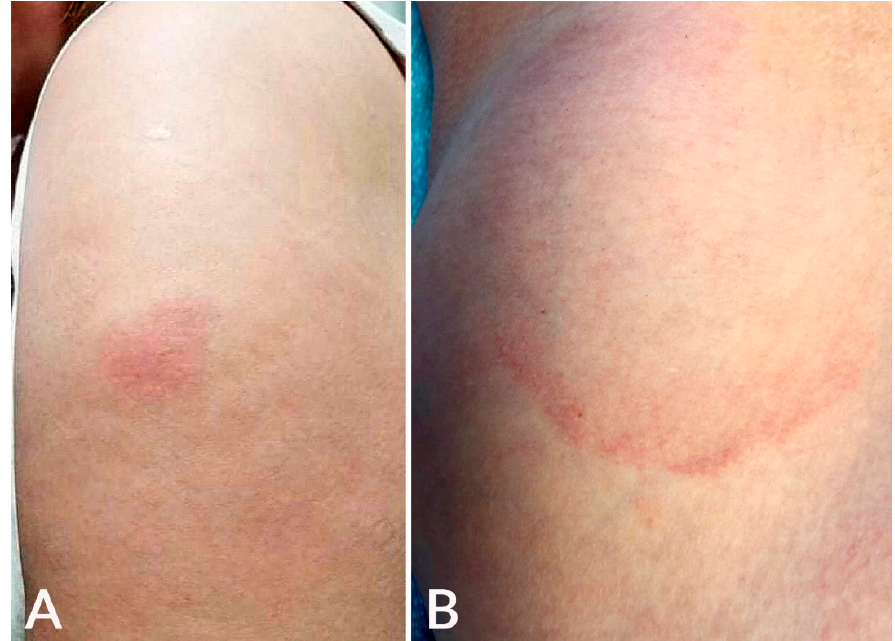
Figure 1. Local injection site reaction: An erythematous plaque developed at the injection site on the left arm 1 day after BNT162b2 vaccination ( A ); delayed large, local reaction: an erythematous, annular, mildly tender plaque developed 6 days after mRNA-1273 vaccination at the injection site on the left arm ( B ).